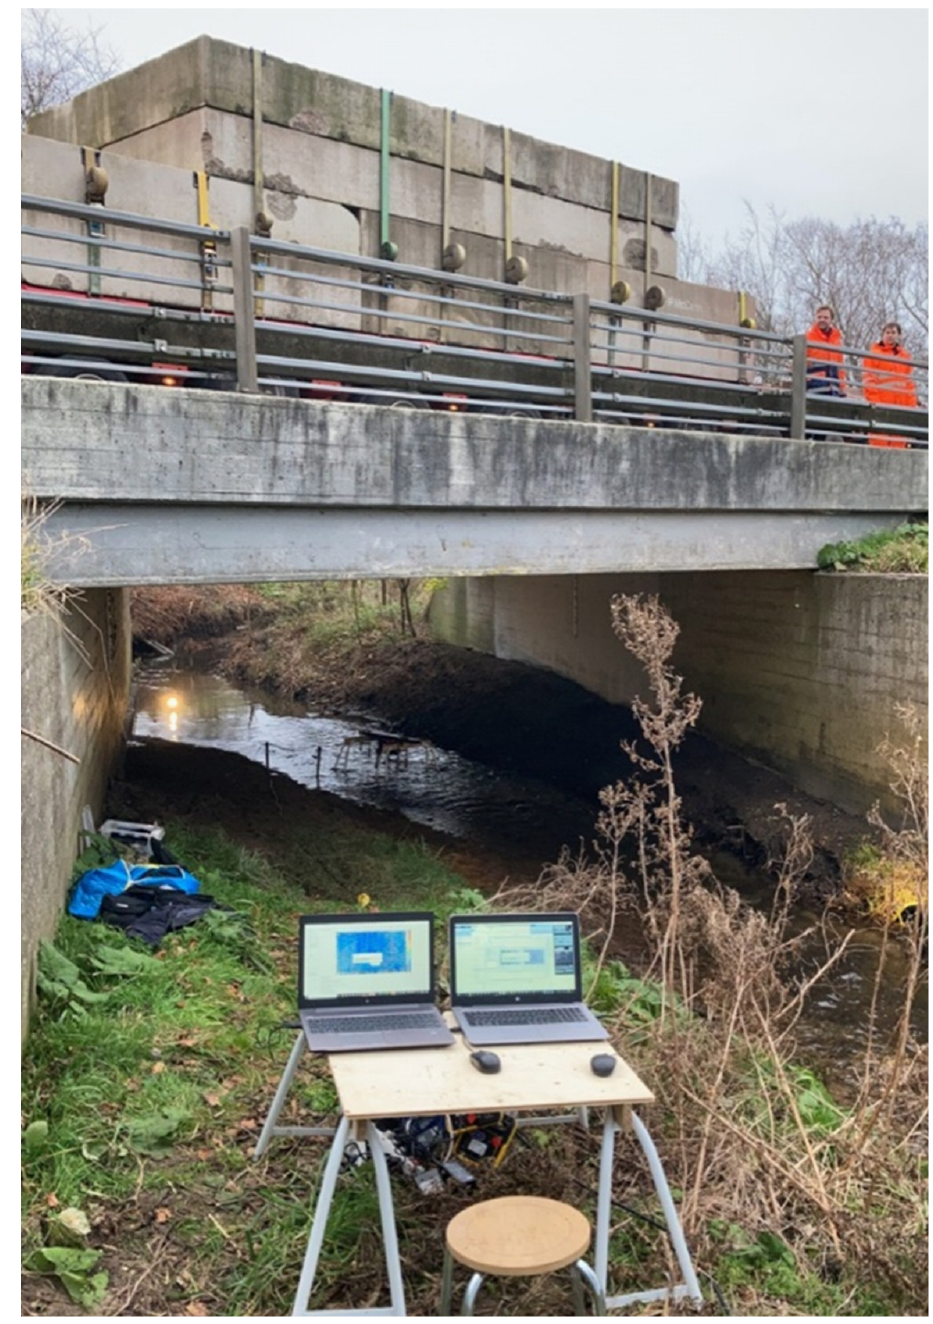
Figure 7. Real-time DIC setup for fi eld testing.